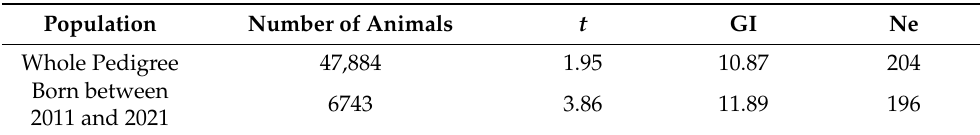
Table 1. Number of animals, number of equivalent complete generations (t), average generation interval (GI) and effective population size computed via individual increase in inbreeding (Ne) for the whole Caballo de Deporte Español Studbook and for the animals born between 2011 and 2021 (reference population).